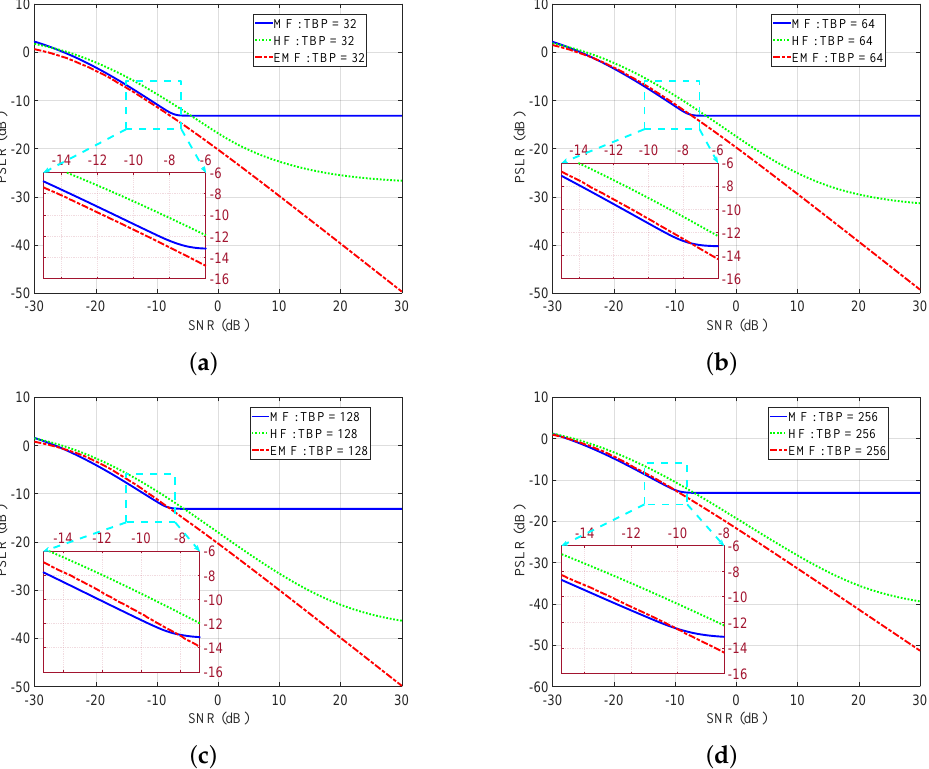
Figure 12a–d shows the SNR versus PSLR, both measured in dB, for different values of TBP—32, 64, 128, and 256. For SNR low values, the HF, MF, and proposed EMF showed almost the same PSLR performance. In Figure 12a–d, EMF shows better PSLR measures than HF. When SNR increased over a certain value, EMF showed better PSLR measures than MF for all values of TBP, due to the effective sidelobe reduction by the EMF. A reduced PSLR indicates an enhanced detection performance.